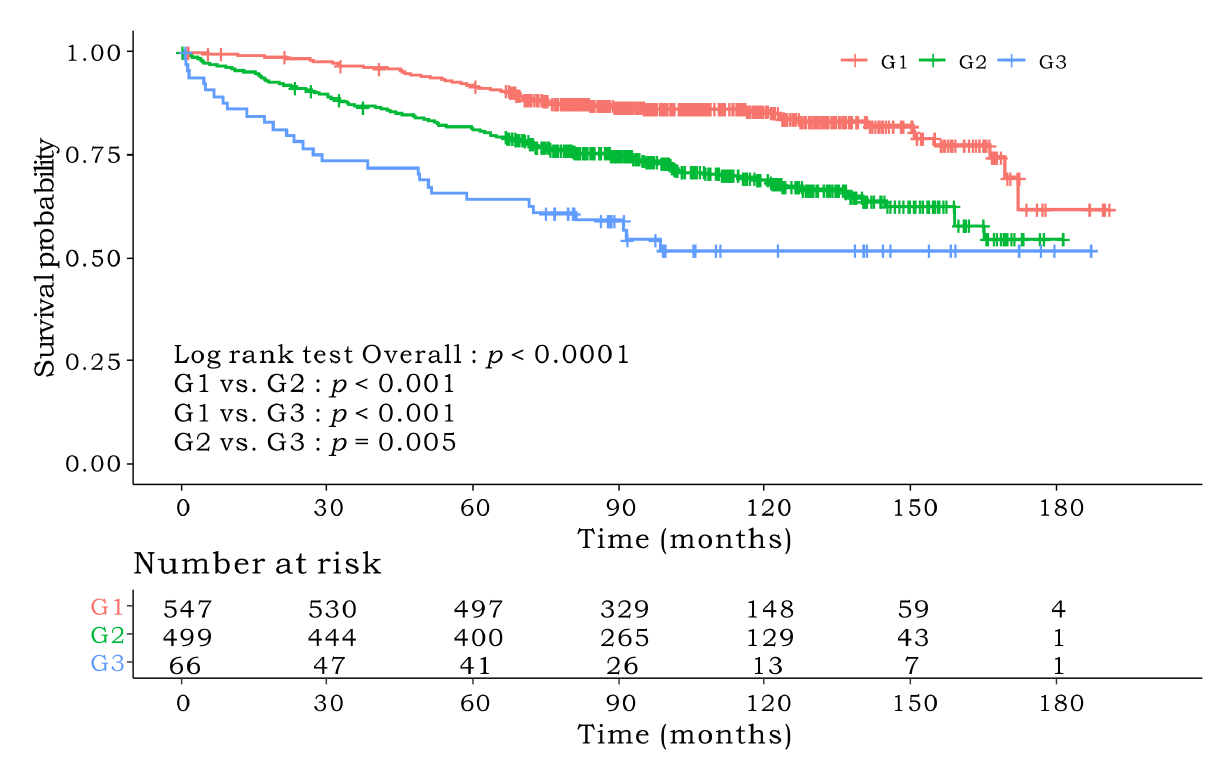
FIGURE 3 The 5-year OS rates of patients in P-CONUT G1, G2, and G3 were 91.7%, 81.2%, and 64.1% ( p < 0.0001), respectively. OS, overall survival; P-CONUT, combination of PNI (prognostic nutritional index) and CONUT (controlling nutritional status).